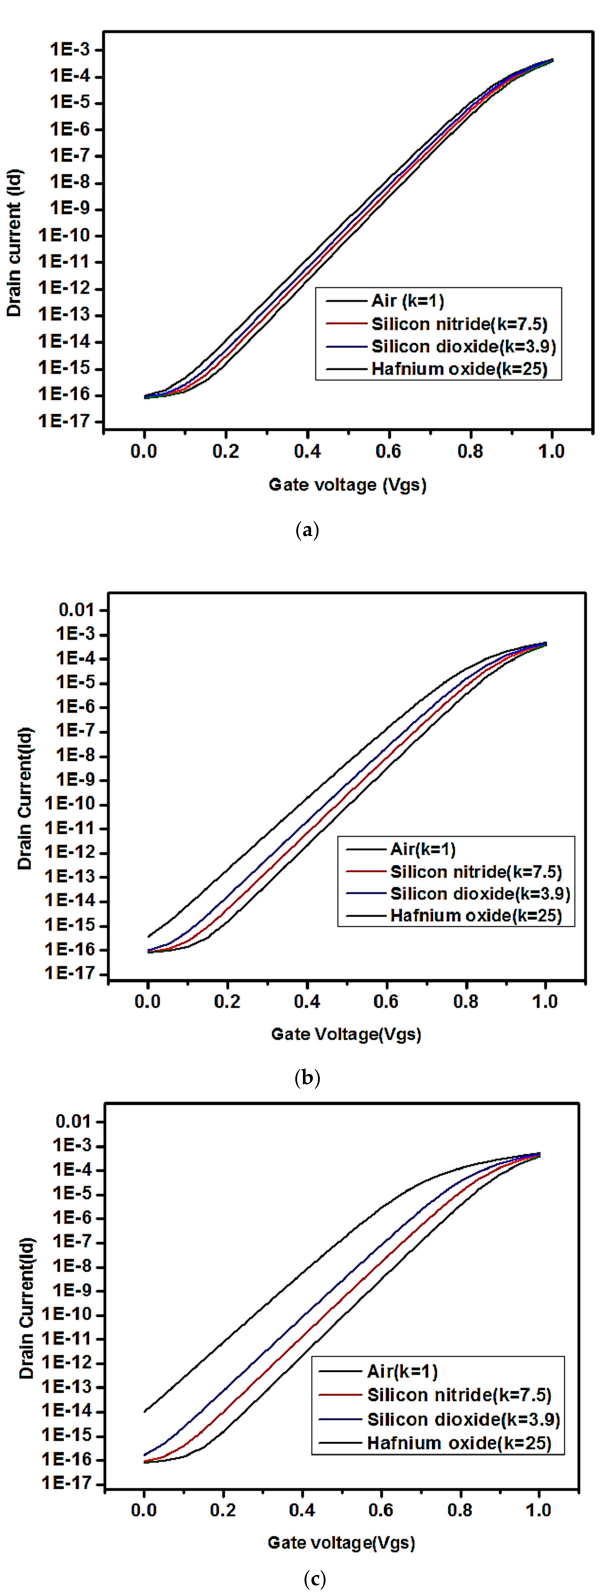
Figure 5. ( a ) Drain current versus gate voltage with different dielectric constants (L cavity = 3 nm); ( b ) Drain current versus gate voltage with different dielectric constants (L cavity = 5 nm); ( c ) Drain current versus gate voltage with different dielectric constants (L cavity = 7 nm).